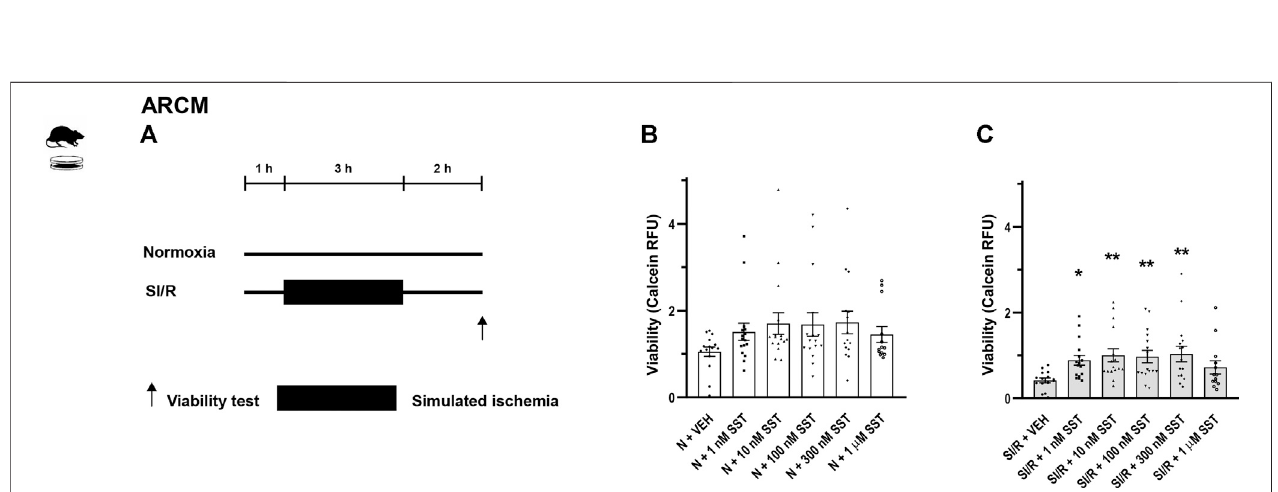
FIGURE1| Invitro simulatedischemia/reperfusion(SI/R)studyprotocolonH9C2cellline (A) .Somatostatin(SST)(1 nM,10 nM,100 nM,and300 nMand1 µM)or its vehicle (VEH) was added to the cells during the whole experiment. Viability of SST-treated H9C2 cells exposed to normoxia (N) (B) or SI/R (C) . Data are presented as mean ± SEM. The Kruskal-Wallis test and Dunn ’ s post hoc test, * p < 0.05; ** p < 0.01 vs. VEH from four independent experiments. RFU: relative fl uorescence unit.